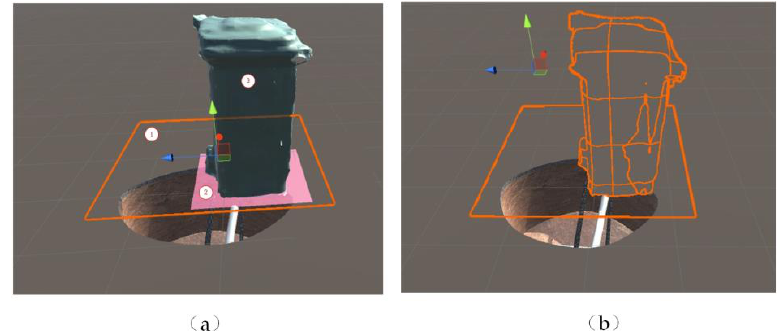
Figure 7. The procedure of occlusion building: ( a ) the mesh component, ( b ) the visual effort of occlusion.